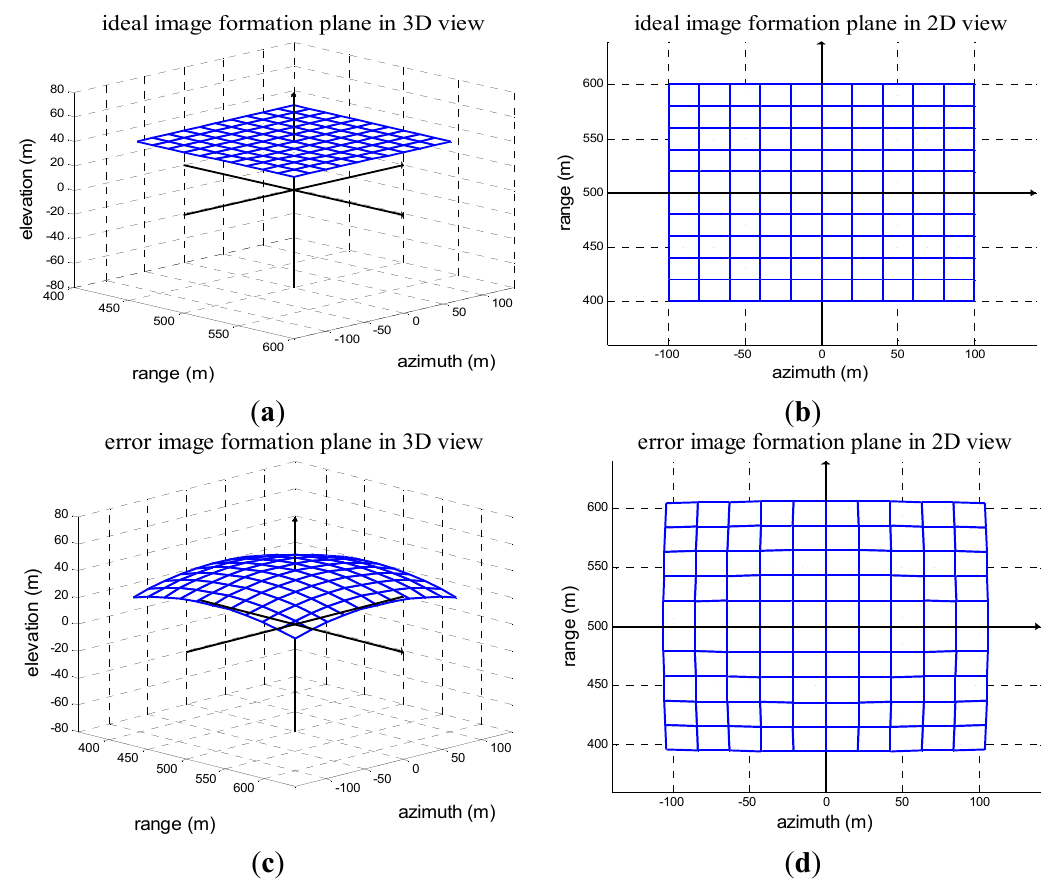
Figure 3. ( a ) Ideal image formation plane in 3D view. ( b ) Ideal image formation plane in 2D view. ( c ) With error image formation plane in 3D view. ( d ) With error image formation plane in 2D view.